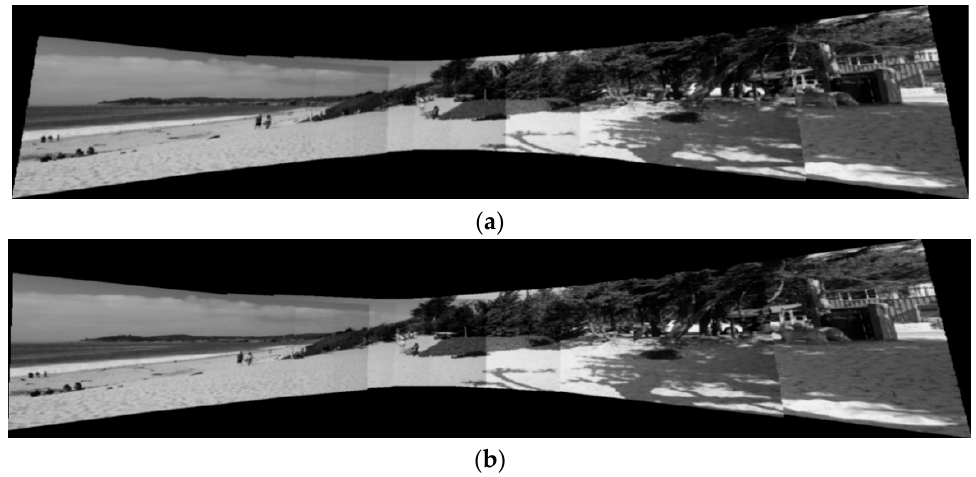
Figure 13 Image stitching results for ( a ) rSYBA and ( b ) SURF on Carmel image sequence. Figure 13. Image stitching results for ( a ) rSYBA and ( b ) SURF on Carmel image Table 5. Average relative error results for 3 × 3 homography matrix across all images. rSYBA SURF